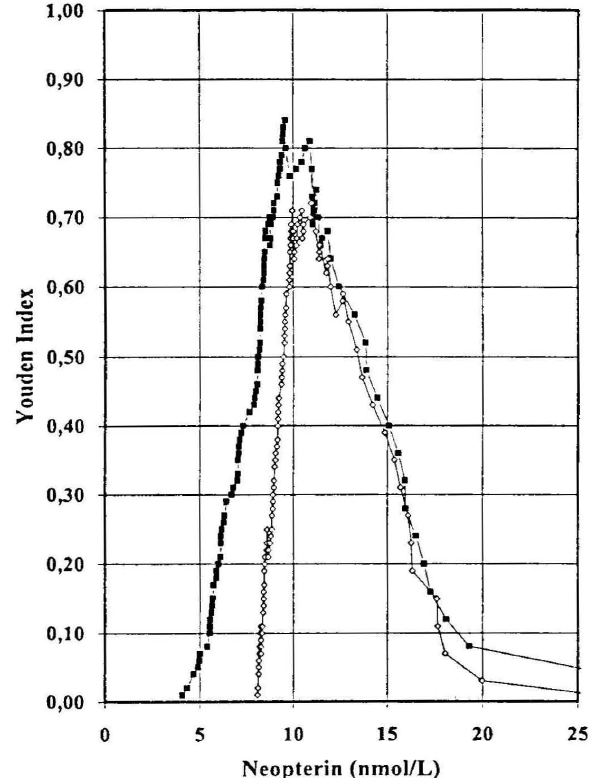
Figure 2. Comparative plots of Youden indices constructed li'om initial results obtaincd by RIA and ELISA tcchnique on \09 blood donors who were classified into two groups accor ding to whether their concentration by HPLC was below and up to. or above 10 nmol/L. Youden index is defined as sensi tivity+specificity-l. Sensitivity means fraction of subjects with HPLC result above 10 nmol/L who had an initial RIA or ELISA result above a chosen cut-off value. Specificity de notes the fraction of subjects with HPLC values below and up to 10 nmollL who had an initial RIA or ELISA result below and up to this chosen cut-olf value. The cut-off values are varied systematically over the whole range of values obser ved by RIA or ELISA and the corresponding sensitivities and specificities are calculated. Thc higher the maximum You den indcx. the bcttcr is the discriminativc power of a diagnostic